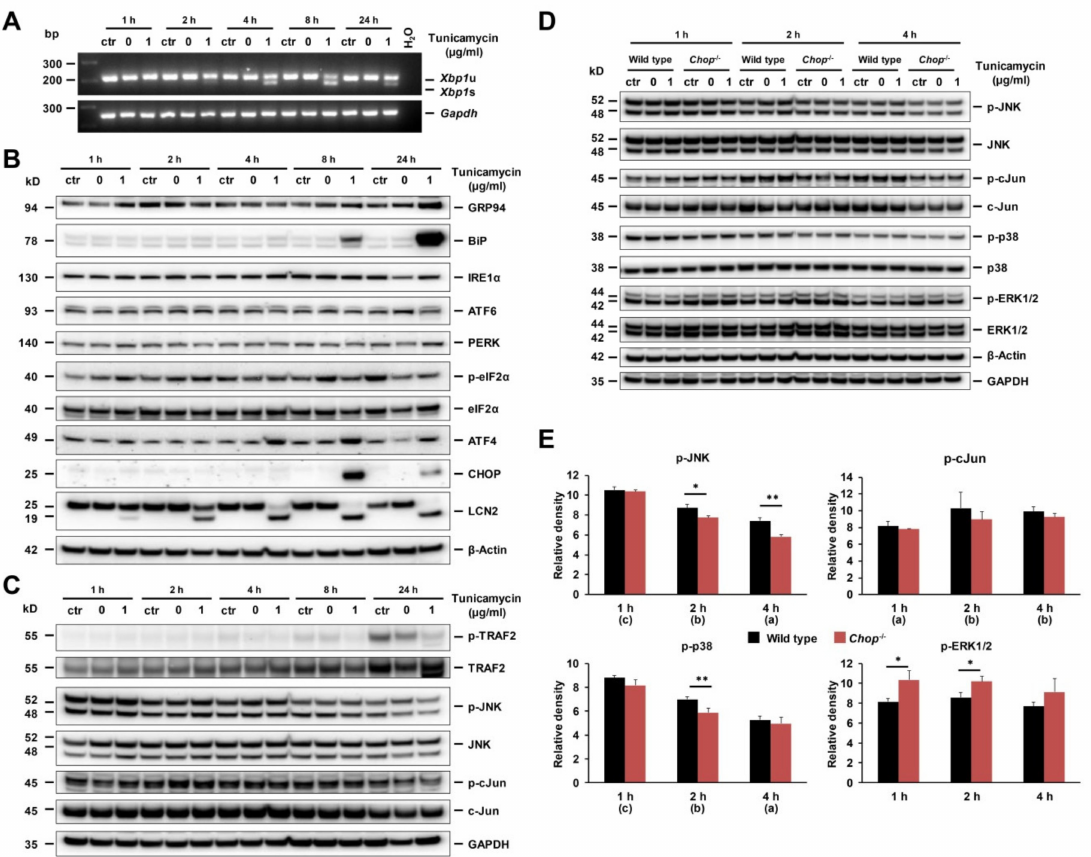
Figure 6. ER stress and UPR in the early stage of tunicamycin (TM) stimulated primary hepatocytes. ( A ) Semi-quantitative PCR of spliced Xbp1 ( Xbp1s ) mRNA of wild type hepatocytes detected as early as 2 h upon TM incubation and increasing over time. ( B ) Western blot analysis of ER stress marker proteins GRP94, BiP, IRE1 α , ATF6, PERK, p-eIF2 α , ATF4, and CHOP, with blockade of LCN2 glycosylation. In this analysis, GAPDH served as loading controls. ( C ) Upon 1 h TM stimulation, phosphorylated JNK reduced continuously, including p-c-Jun, but at a slower pace corresponding to p-JNK, with GAPDH as loading control. ( D ) Baseline levels of p-JNK, p-c-Jun and p-38 in Chop − / − hepatocytes showed lower compared to wild type and decreasing over time, while p-ERK1 / 2 remained high. ( E ) Western blot density graph from ( D ) . Details about the statistics are given in Supplementary Table